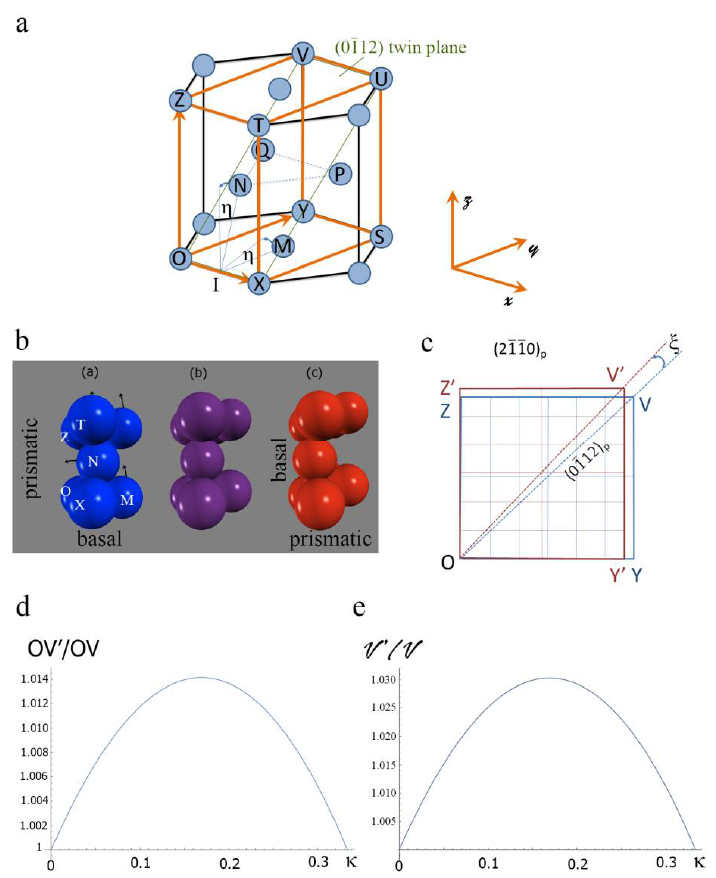
Figure 28. Hard-sphere displacive model of extension twinning in magnesium. ( a ) Unit cell with labels O , X , M , N , Z , and T given to the magnesium atoms. ( b ) Schematic view of the atomic displacements associated with a stretch distortion; ( c ) obliquity ξ of the {0112} plane that should be compensated for; ( d ) evolution of the distance OV belonging to the {0112} plane; and ( e ) change of the unit volume during the distortion process, as functions of κ, the cosine of the angular parameter η. Adapted from [130].